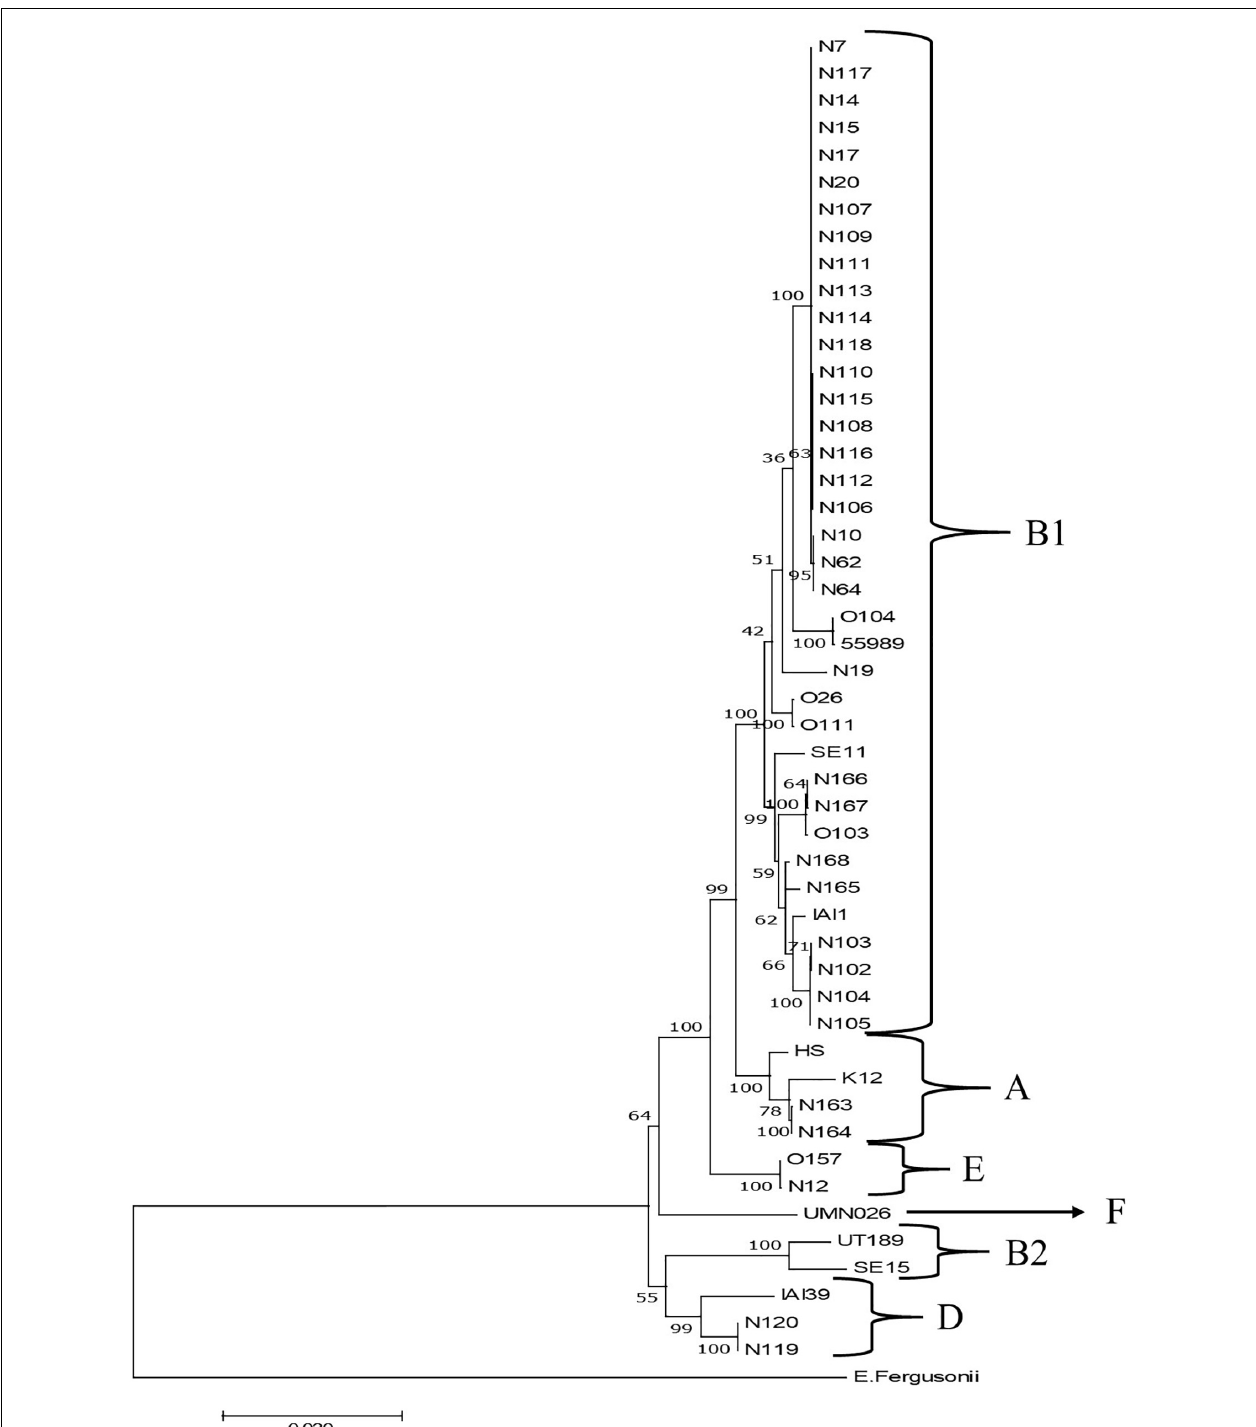
FIGURE 4 | Maximum likelihood phylogenetic comparison of 35 STECs from different ecosystems on the Nijkerk cattle farm and 15 E. coli / Escherichia fergusonii strains. The tree was rooted using E. fergusonii (ATCC35469) as outgroup. Phylogenetic relationships between E. coli strains were inferred by making use of 10 concatenated household genes ( adk , fum C, glp K, gyr B, icd , lys A, mdh , met G, pur A, and rec A) with 1,000 bootstrap iterations. Relevant phylogenetic groups (A, B1, B2, D, E, and F) are indicated in the tree. Reference strain abbreviations: HS, O9:H4 strain HS; K12, O16:H48 K12 strain MG1655; O104, O104:H4 strain 2011C-3493; 55989, O104:H4 strain 55989; O103, O103:H2 strain 12009; SE11, O173:H4 strain SE11; O26, O26:H11 strain 11368; O111, O111:H8 strain 11128; IAI1, O8:H9 strain IAI1; SE15, O150:H5 strain SE15; UT189, O18:H7 strain UT189; UMNO26, O17:H18 strain UMN026; O157, O157:H7 Sakai strain; IAI39, O7:H45 strain IAI39; E. fergusonii , E. fergusonii ATCC35469.